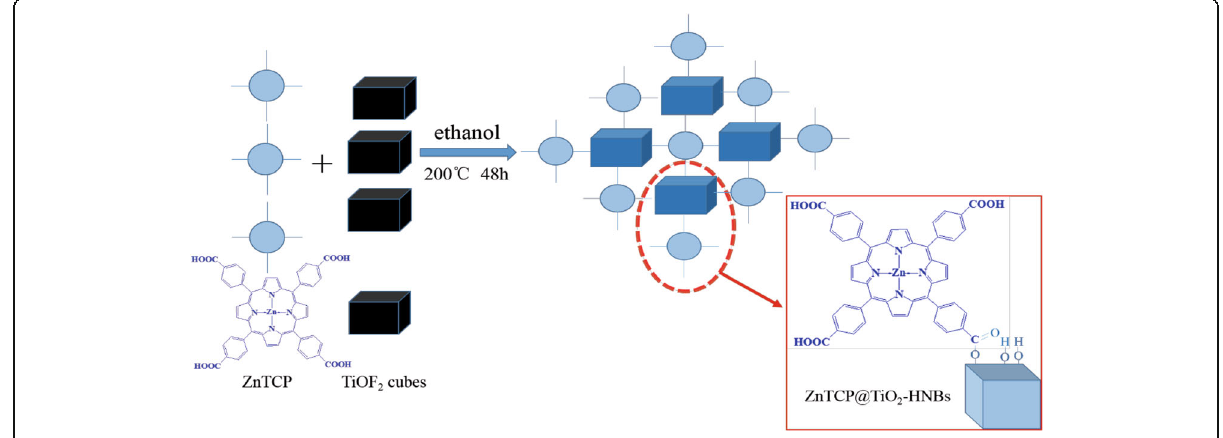
Fig. 3 The proposed formation process of Zn(II) porphyrin sensitized TiO 2 -HNBs (ZnTCP@TiO 2 -HNBs)